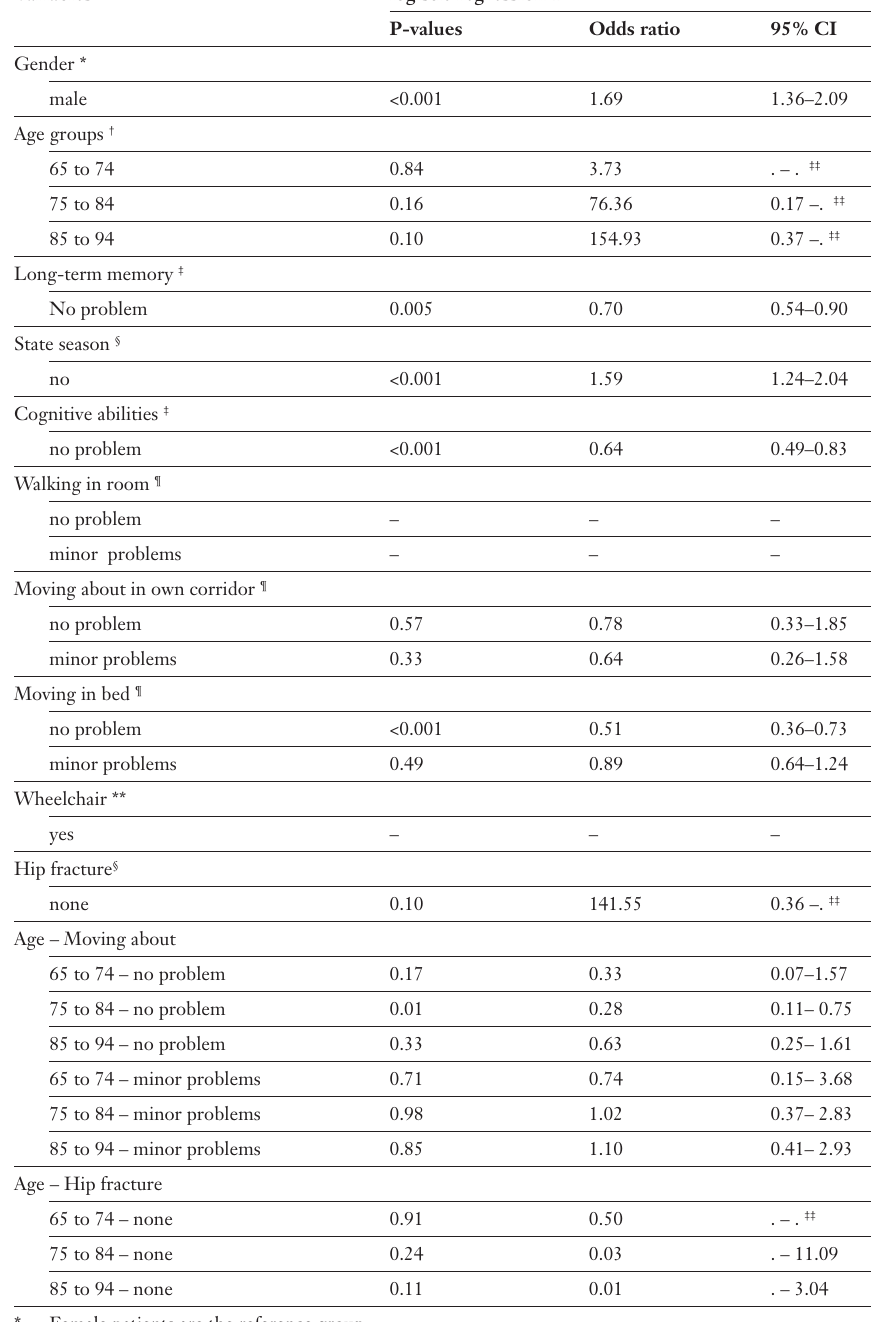
P-values and odds ratio for urinary incontinence at